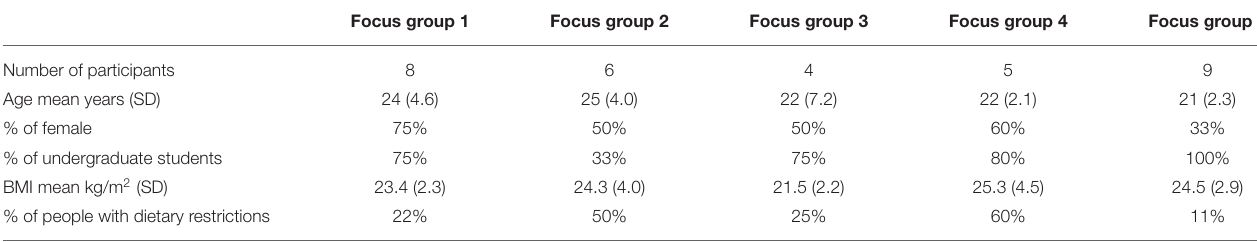
TABLE 1 | Focus group participants’